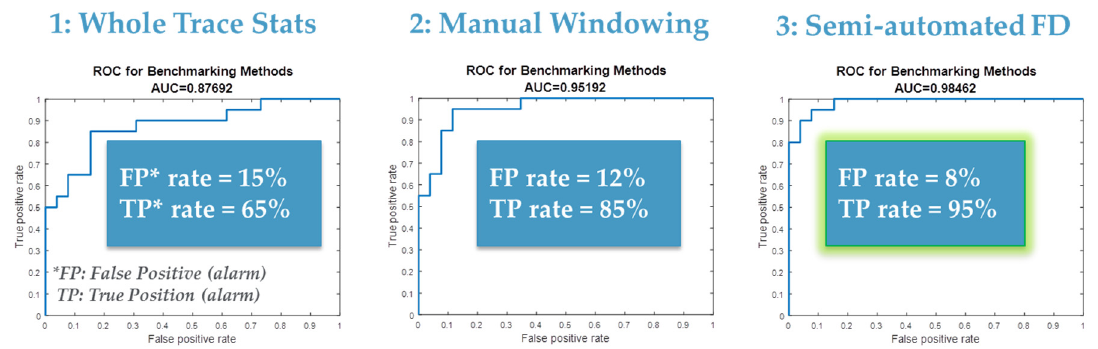
Figure 6. Results of applying fault detection and classification (FDC) with semi ‐ automated trace partitioning and feature extraction.